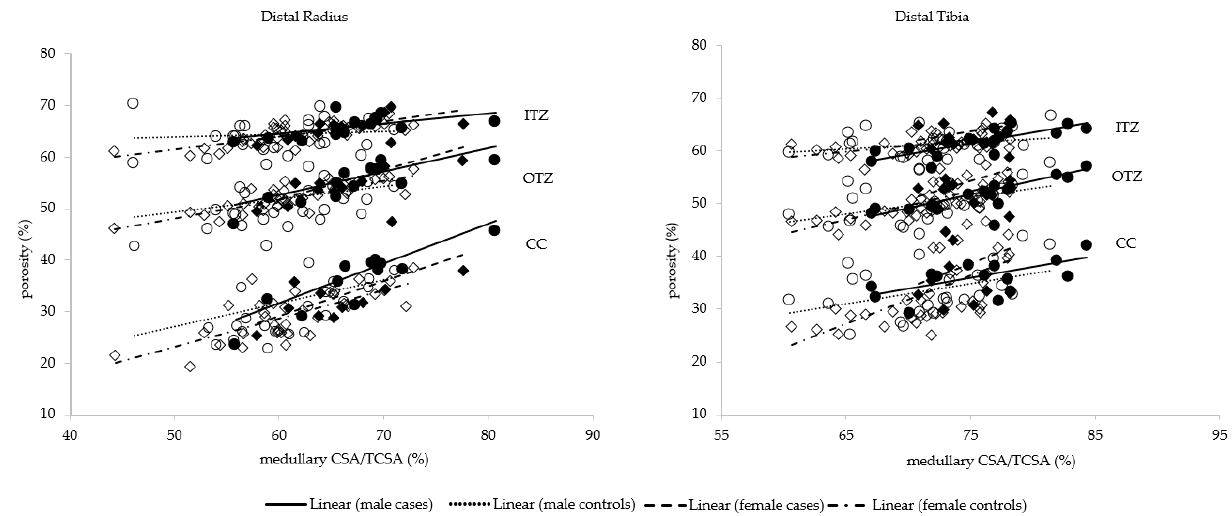
Figure 2. Porosity of the compact appearing cortex (CC), outer and inner transitional zones (OTZ, ITZ) as a function of medullary cross-sectional area (CSA)/total CSA at the distal radius and distal tibia in male cases (filled dots), male controls (open dots), female cases (filled squares) and female controls (open squares). All p < 0.001 except for the distal radius ITZ in males ( p =